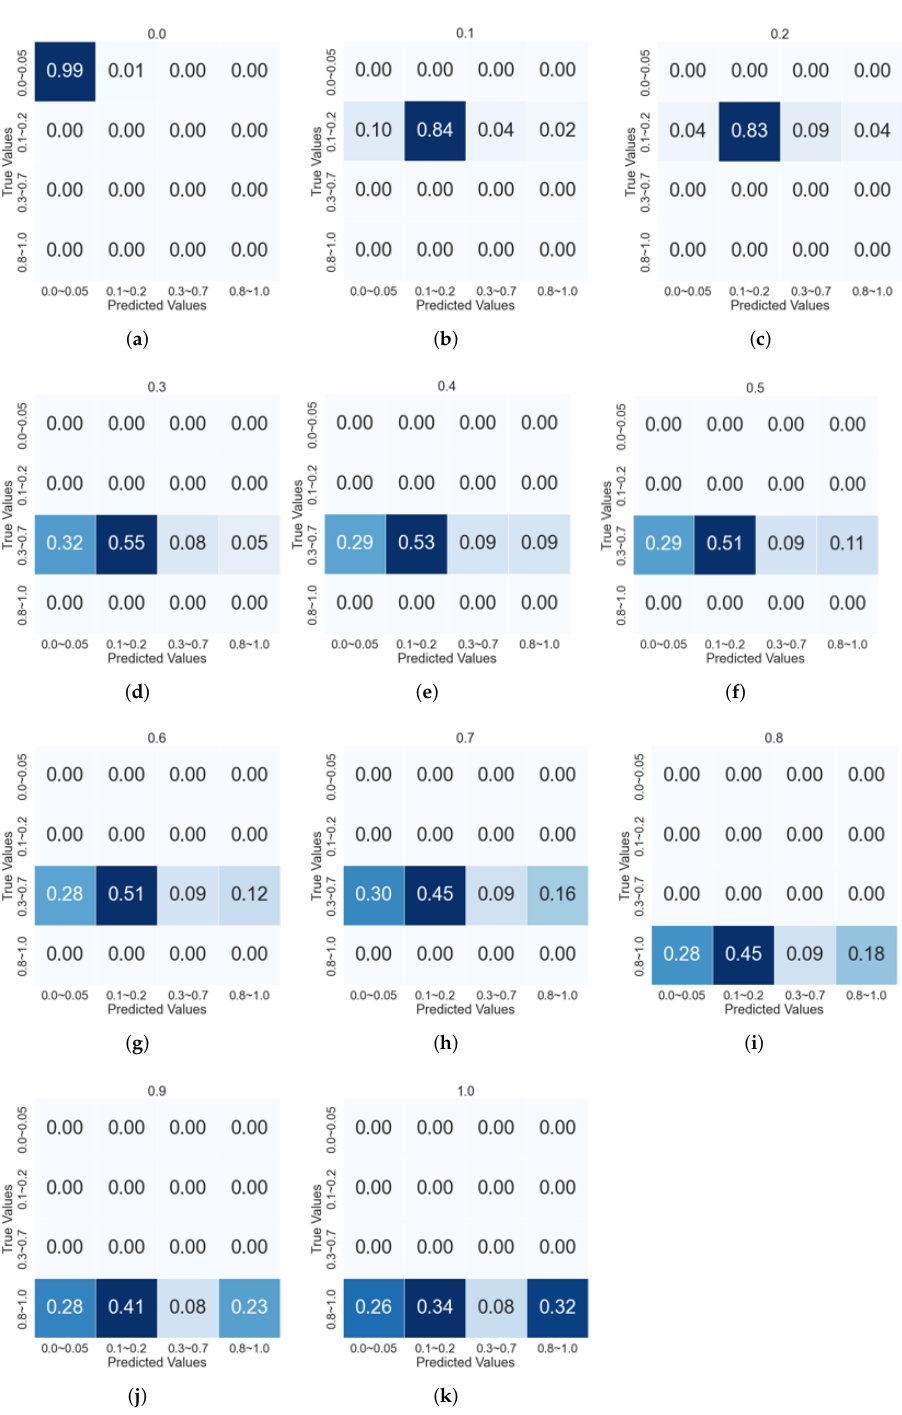
Figure 4. Confusion matrices from 4-Class VA Classifier’s classification results for 11 classes of fundus images. ( a ) Class-0.0; ( b ) Class-0.1; ( c ) Class-0.2; ( d ) Class-0.3; ( e ) Class-0.4; ( f ) Class-0.5; ( g ) Class-0.6; ( h ) Class-0.7; ( i ) Class-0.8; ( j ) Class-0.9; ( k )